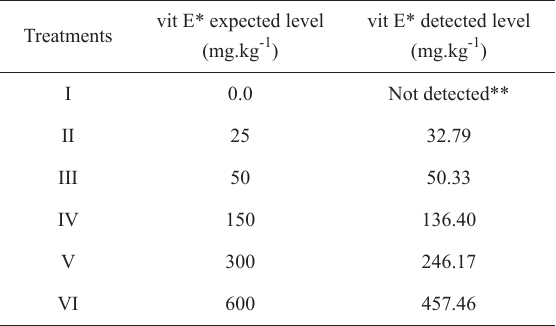
Expected and detected vitamin E levels in experimental